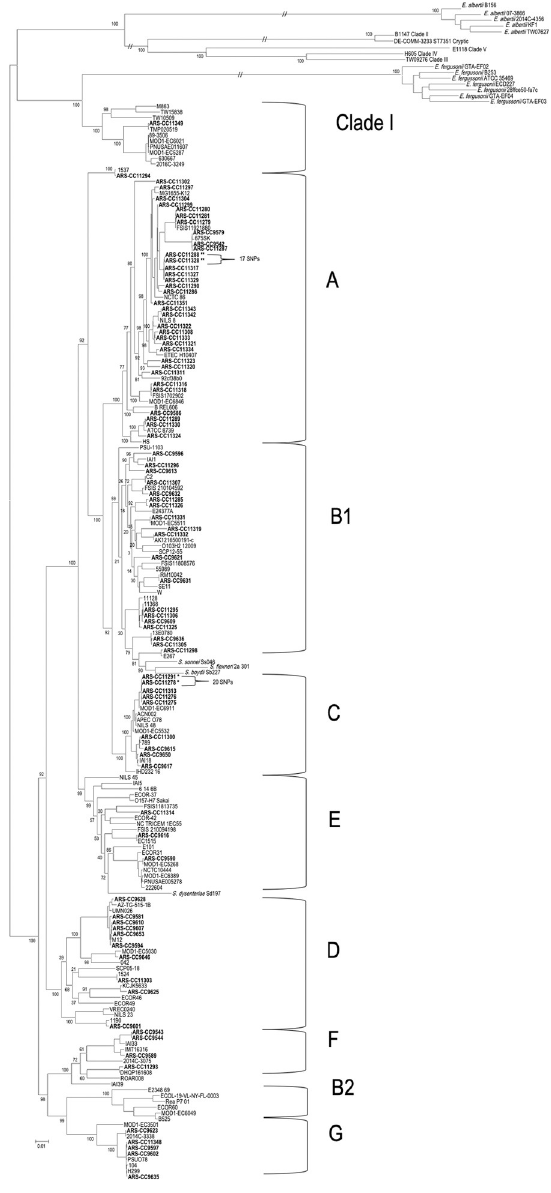
Fig 1. Maximum likelihood tree showing the inferred phylogeny of strains analyzed in this study (in bold with “ARS-CC” prefix) along with previously characterized strains from each phylogroup, cryptic clade, and E . albertii , and E . fergusonii , with 1000 bootstrap replicates. Brackets on right show phylogroups. The two inner brackets show the SNP differences between closely related strains. The bar on the bottom left shows substitutions per